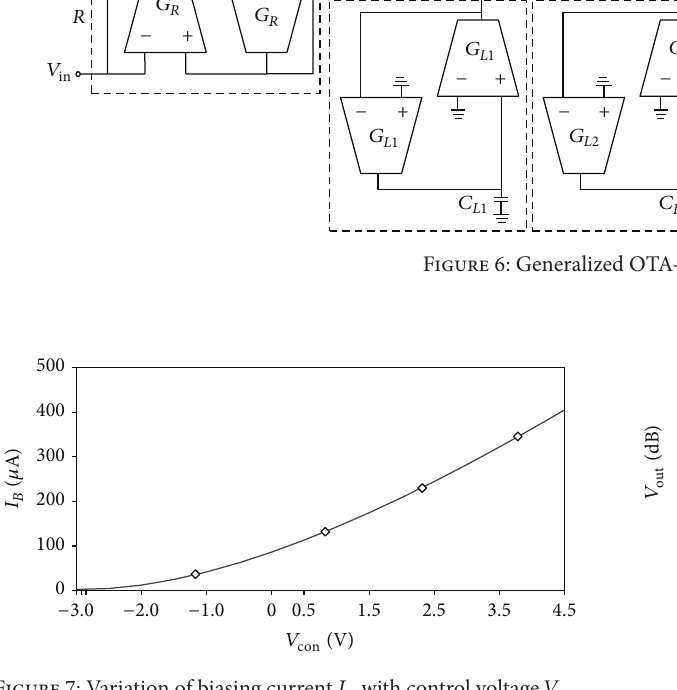
Figure 7: Variation of biasing current 𝐼 𝐵 with control voltage 𝑉